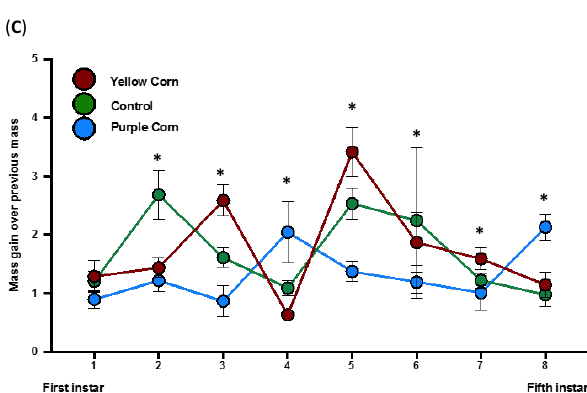
Figure 5. Mean larval mass gain from first instar to third instar ( A ) and mass gain from third instar to fifth instar ( B ) among di ff erent treatments. Due to huge variation of larval mass scale from first instar to fifth instar, we split larval mass analysis into two parts. Mean instar-specifc larval mass gain from first instar to fifth instar stage ( C ). Means with an asterisk above indicate a significant di ff erence between treatments (Kruskal–Wallis tests, Dunn’s multiple comparison test, p < 0.05)